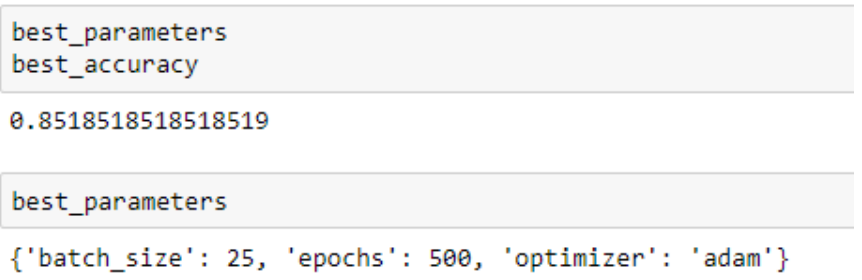
Figure 40. The best parameters with obtained after performing grid search with 10-Fold Cross- Validation on the ANN (3-20-20-1) model.